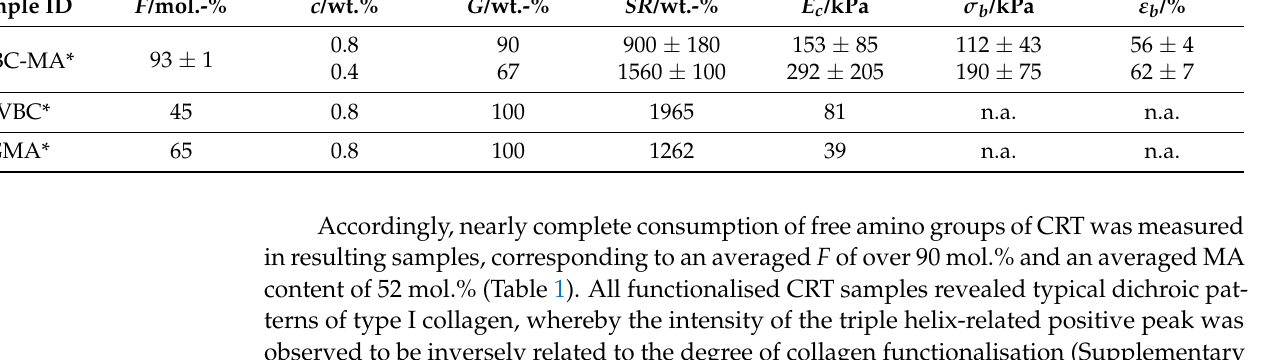
Table 1. Molecular and thermo-mechanical characteristics of UV-cured CRT hydrogels. n.a.: not available. Sample